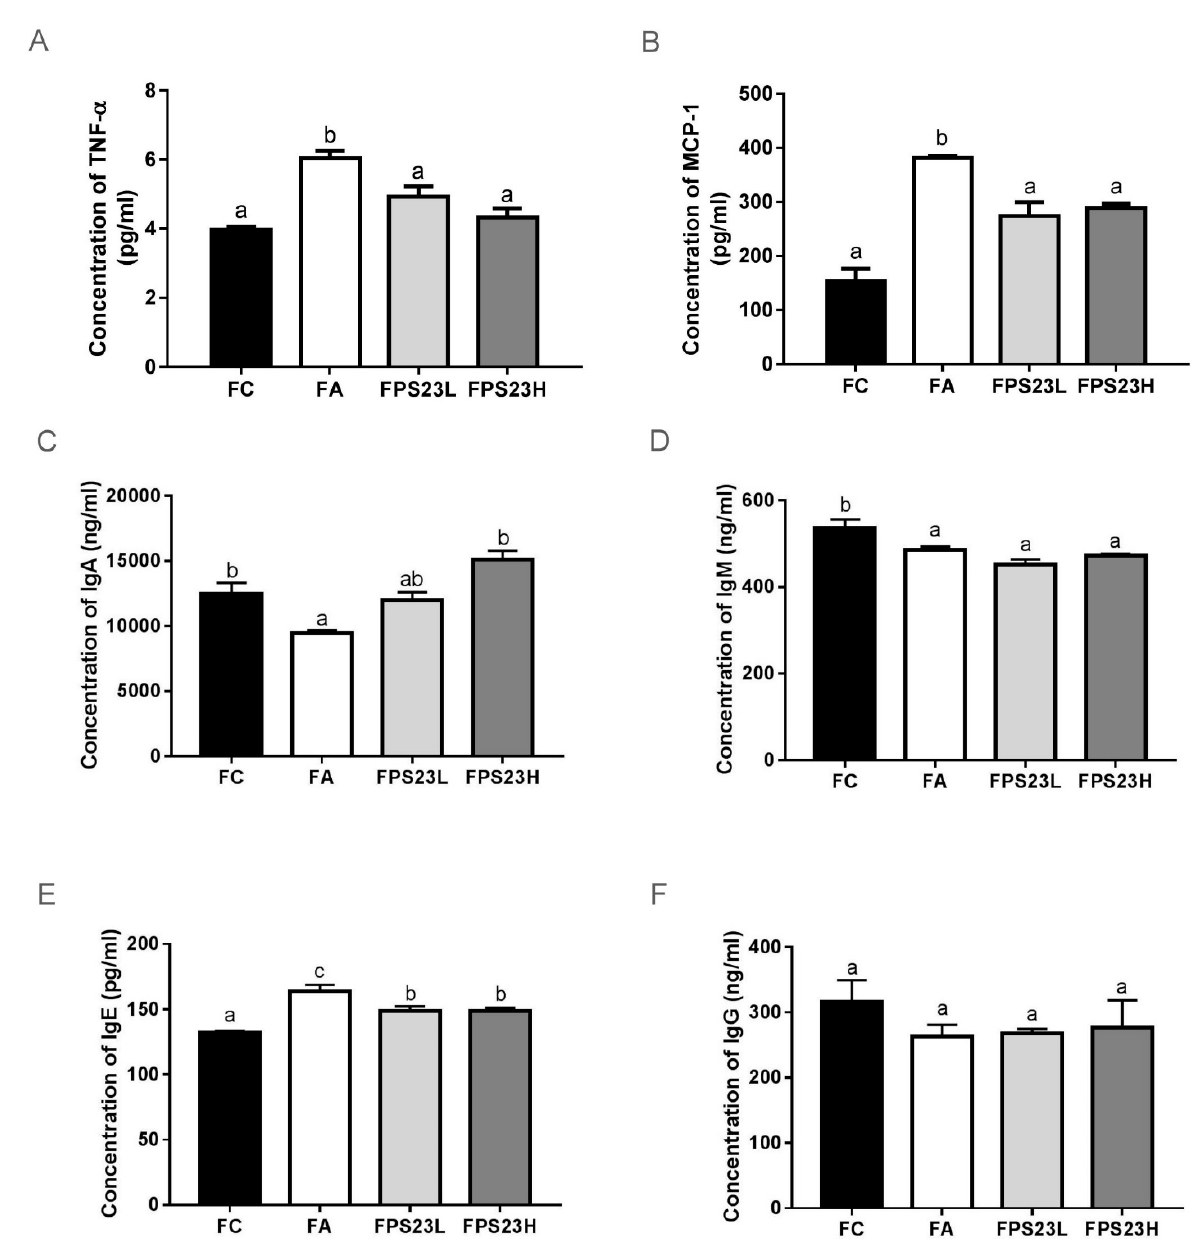
Figure 4. Pro-inflammatory cytokines and immunoglobulins in the intestinal mucosa. ( A ) TNF- α ; ( B ) MCP-1; ( C ) IgA; ( D ) IgM; ( E ) IgE; ( F ) IgG in the SAMP8 mice. Different superscript letters (a, b, c) indicate significant differences in one-way ANOVA by Tukey HSD post-hoc test ( p < 0.05). n = 4.